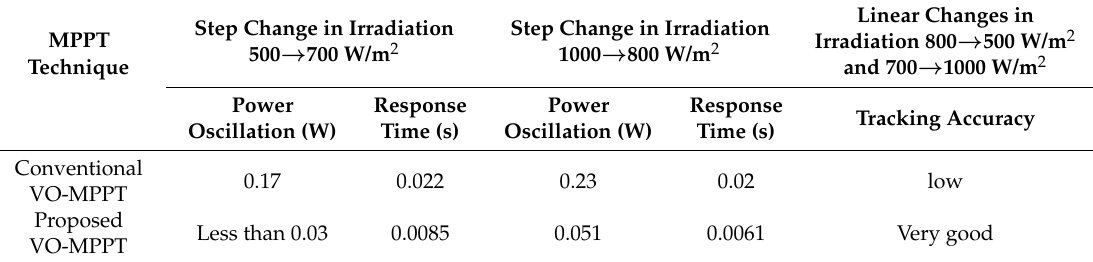
Figure 14. Extracted PV power with conventional and proposed VO-MPPT methods. Table 1. Comparison results for MPPT